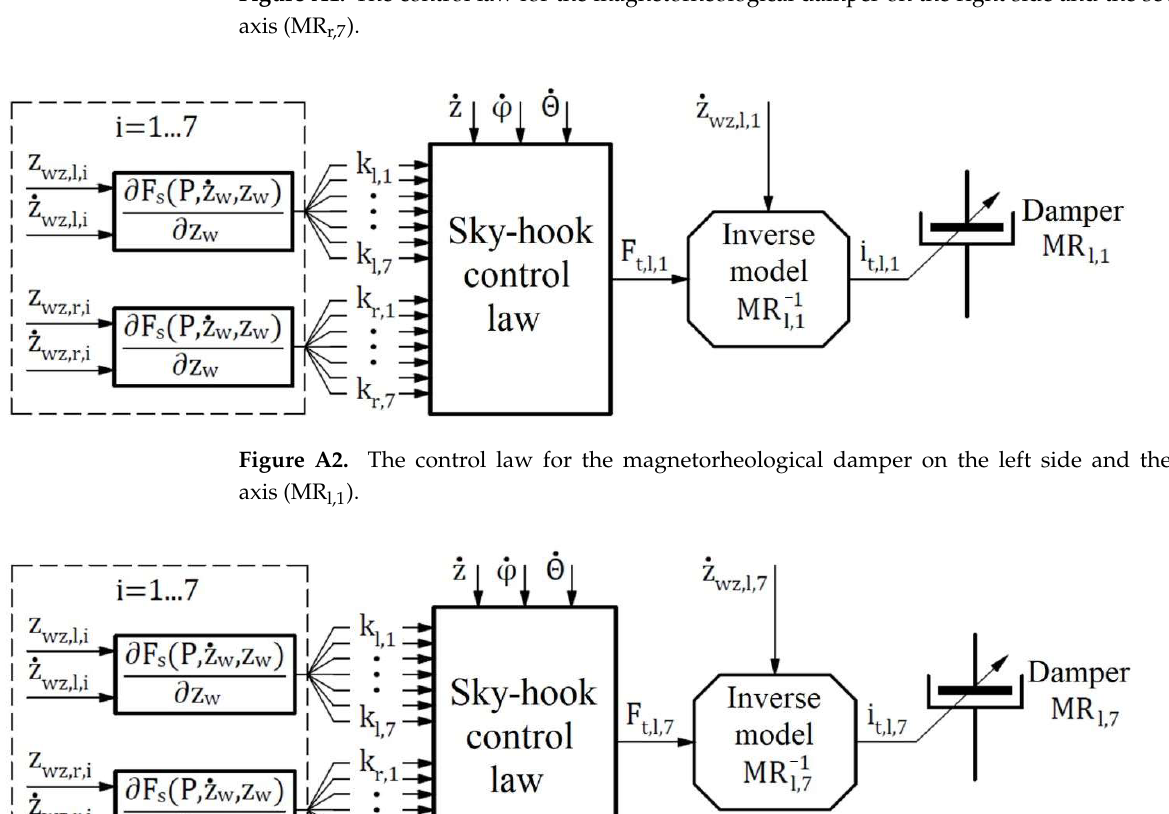
Figure A3. The control law for the magnetorheological damper on the left side and the seventh axis (MR l,7 ).